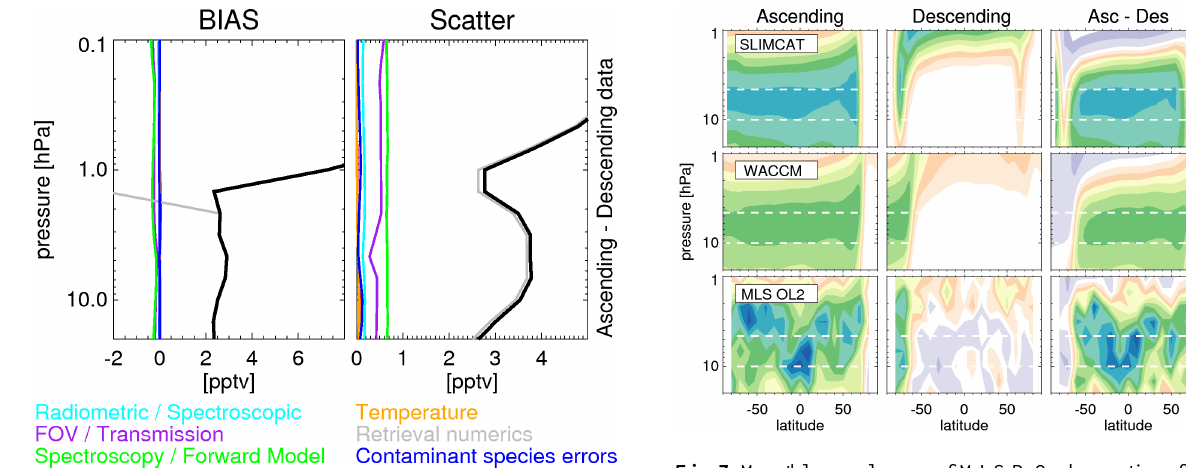
Fig. 7. Monthly zonal mean of MLS BrO observations for ascend- ing and descending phases of the orbits as well as the SLIMCAT and WACCM models for January 2005. To alleviate biases in the MLS BrO data, the ascending-descending differences are used as a measure of daytime BrO for pressure greater than 4.6hPa where the nighttime BrO is expected to be zero. The region between the white dashed lines indicates where the MLS ascending-descending difference are suitable for scientific